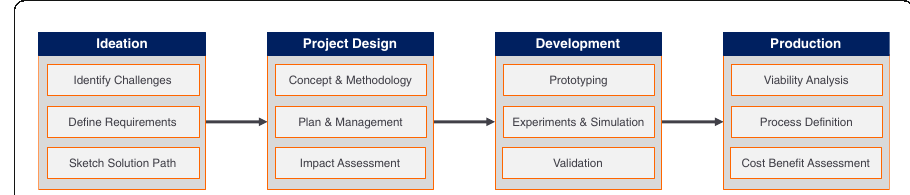
Fig. 4 Proposed R&D Cooperation Strategy (Own